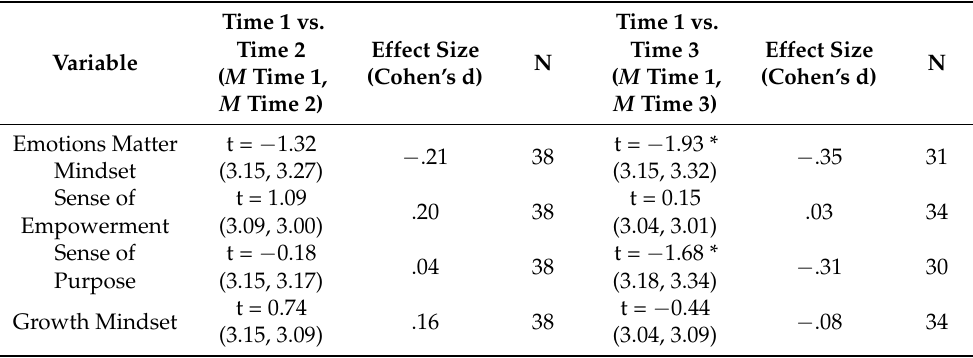
Table 2. Changes in inspirED Team Member